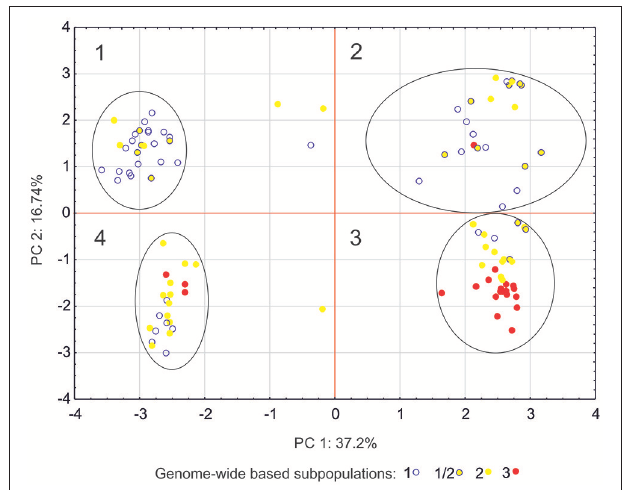
FIGURE 2 | Principal component analysis (PCA) for markers associated with the studied traits and connected with the sequences identified in databases as a part of potential genes. Affinity of each genotype to one of the groupings (“candidate genes subpopulation”) can be found in Table S1 .